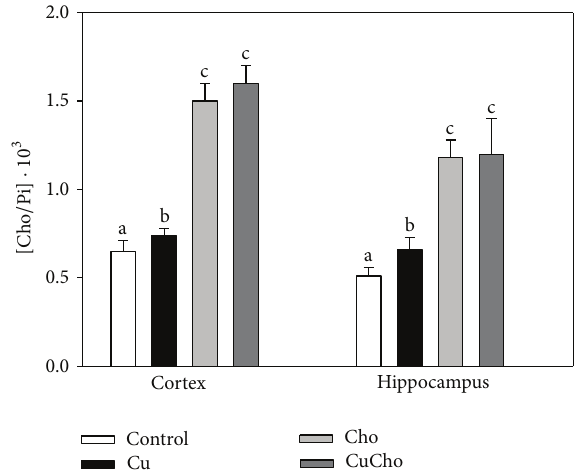
Figure 2: Cholesterol (Cho) and total phospholipids (measured as total inorganic phosphate or Pi) ratio (Cho/Pi) in brain cortex and hippocampus homogenates (ng/mg total protein). Samples were analyzed as indicated in Section 2.7. Treatments are indicated with different colors, control (white bars), Cu (black bars), Cho (gray bars), and CuCho (dark gray bars). Results are expressed as mean of 10 rats assayed in triplicate ± standard deviation (SD). Significant differences among the experimental groups are indicated with superscript letters (values with distinct letters are significantly different between them, 𝑃 < 0.01